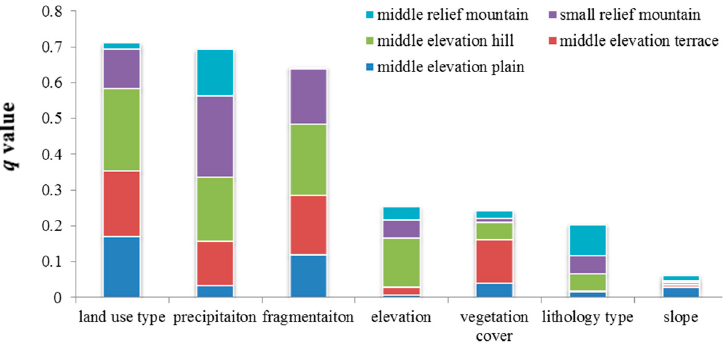
Figure 2. The q values of the factors influencing the total river runoff in the different geomorphic regions.